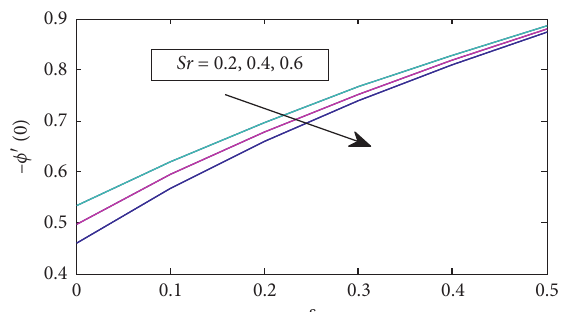
Figure 25: Local Sherwood number for different values of Sr versus ε .